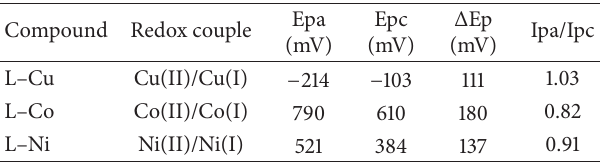
Table 4: Electrochemical parameters for Cu(II), Co(II), and Ni(II) complexes.